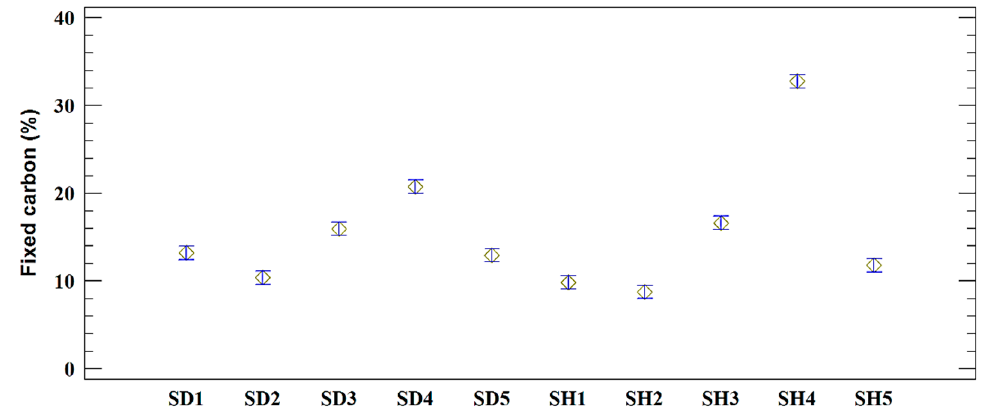
Figure 7. Fixed carbon for the sawdust (SD) and shavings (SH) samples (%).